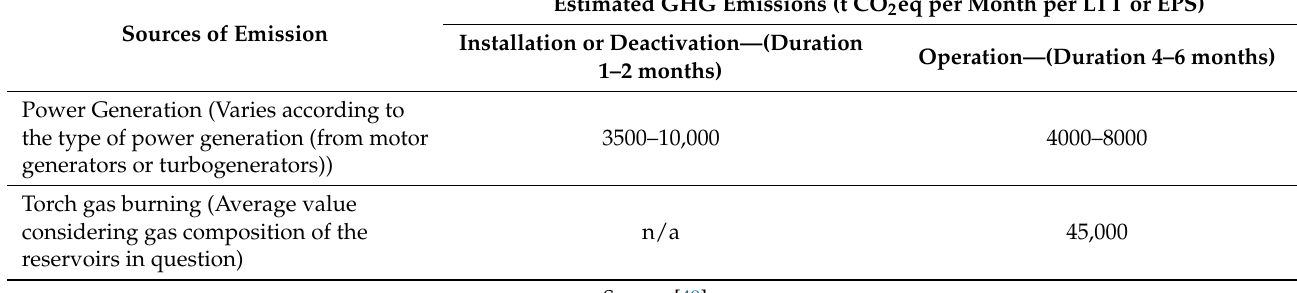
Table 4. Average estimated greenhouse emissions (GHG) by long-term test (LTT) or early production system (EPS) activity in the Stage 2 project.